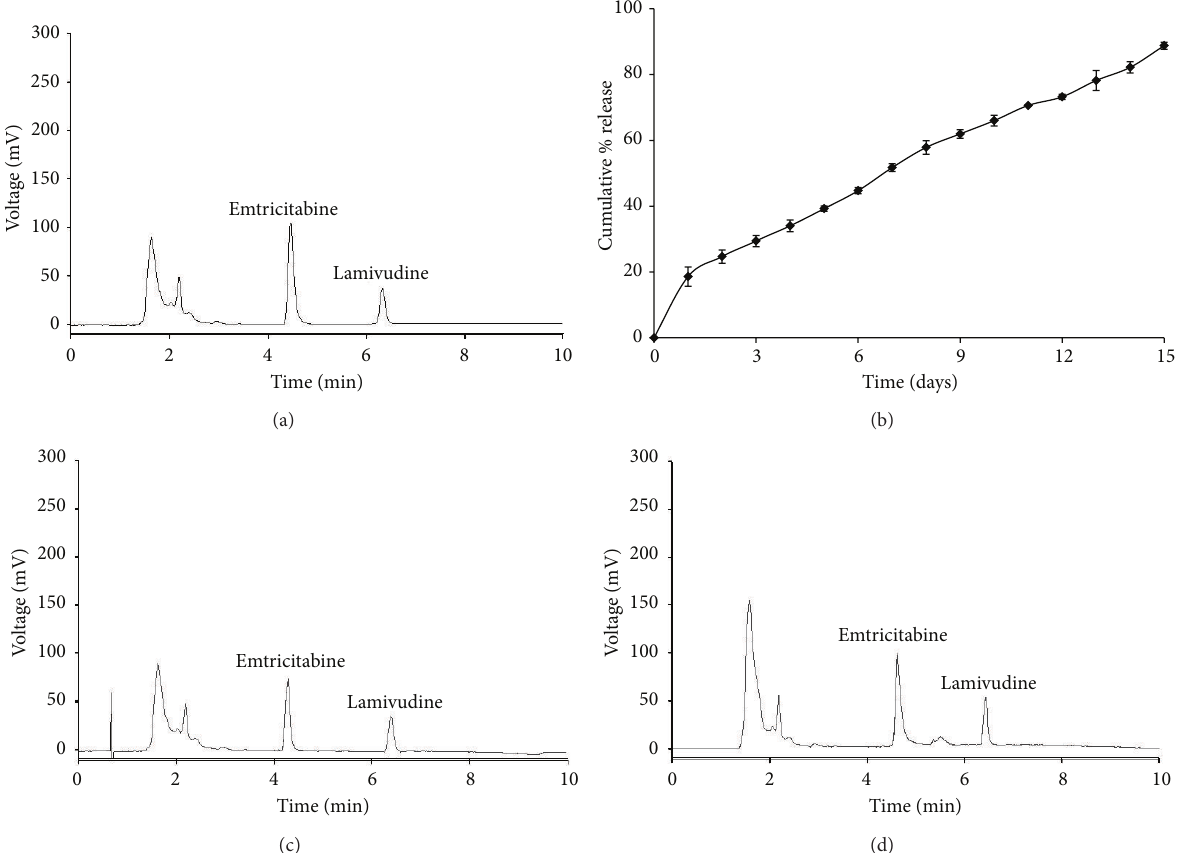
Figure 4: Optimized conditions: (a) chromatographic profile of the plasma spiked with emtricitabine (2 𝜇 g/mL) in the presence of the I.S lamivudine 0.2 𝜇 g/mL at pH value of 3.2 and identical compositions of mobile phase (phosphate dihydrogen phosphate buffer :methanol (40mM) (85 :15 v/v)) at a flow rate of 1mL/min. (b) In vitro release profiles of emtricitabine loaded PLGA (50 :50) (M.W 14,500 da) nanoparticles with cetrimide as stabilizer in pH 7.4 phosphate buffer. Data points shown are mean ± standard deviation (𝑛 = 3) . (c) Chromatogram of plasma sample collected from rats 2h after administration of free emtricitabine. (d) Chromatogram of plasma sample collected from rats 16 h after receiving oral administration of emtricitabine